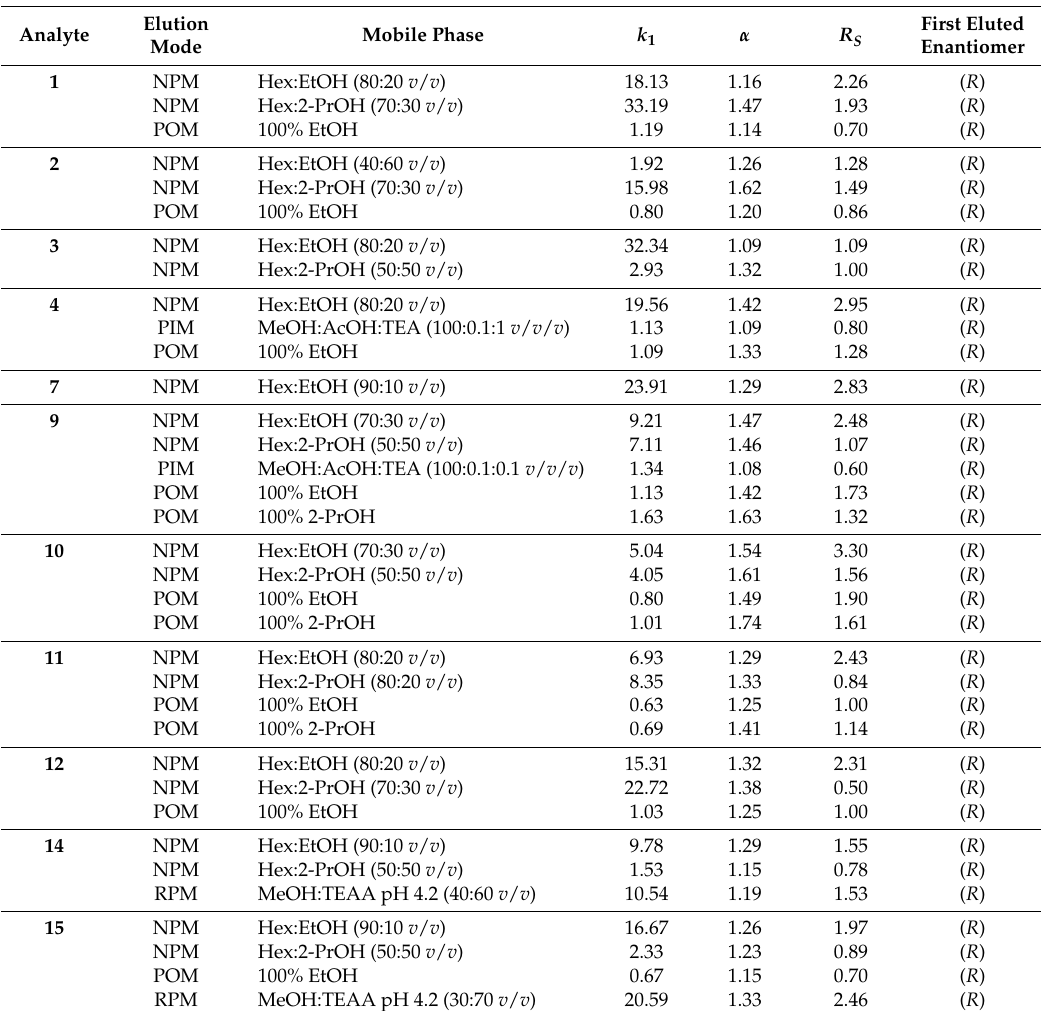
Table 1. Chromatographic data, retention factor of first eluted enantiomer ( k 1 ), separation factor ( α ), resolution ( R S ), and elution order, for the chiral xanthonic analytes on Chirobiotic TM T column, under multimodal chromatographic